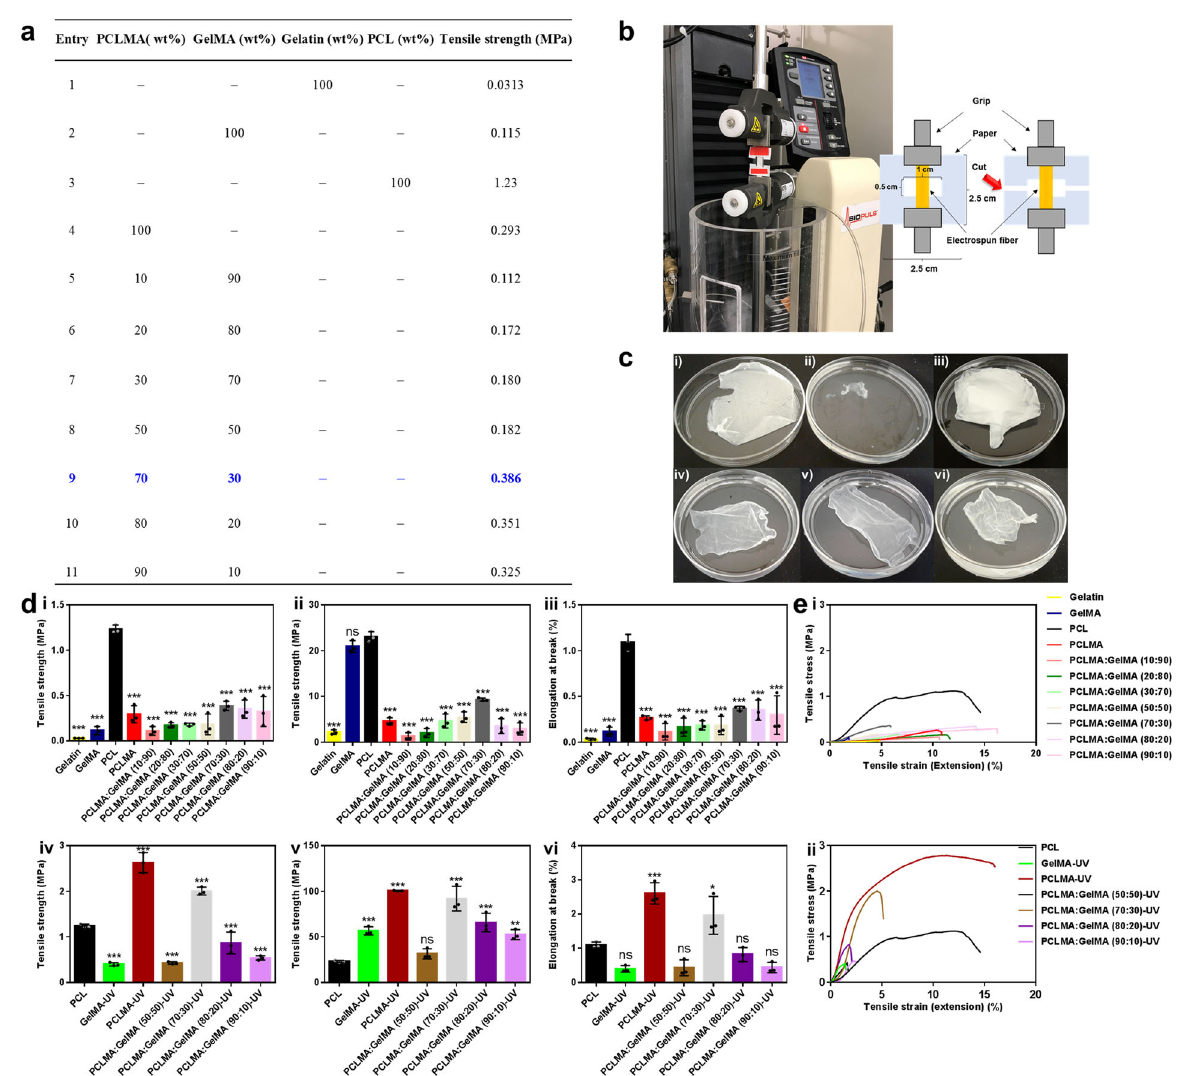
Fig. 3 Screening studies and mechanical evaluation of various nano fi ber compositions. a Table demonstrating the various compositions and their respective tensile strength. All the pure fi bers were prepared in a 10 wt.% stock solution and mixed in various ratios, therefore, the wt.% in the table indicates wt.% employed of the stock solution. For all the sample mixtures prior to electrospinning, Hexa fl uoroisopropan-2-ol (HFIP) was employed as the solvent and the fi nal volume for each solution was 5 ml. b The tensile test setup of the electrospun fi bers with a mechanical tester. c Images of the electrospun fi bers. i GelMA fi ber in a petri dish. ii GelMA fi ber in phosphate-buffered saline (PBS) immediately disintegrated. iii The hydrophobic and stable PCL fi ber in PBS solution. iv The stable PCLMA fi ber in PBS. v The PCLMA:GelMA (70:30) fi ber blend in PBS. vi The PCLMA:GelMA (70:30) fi ber blend after UV crosslinking in PBS. d Mechanical data of the various electrospun fi bers before crosslinking i tensile strength, ii elastic modulus, and iii elastic elongation at break, and correspondingly after crosslinking iv tensile strength, v elastic modulus and vi and elastic elongation at break. e The tensile stress vs. tensile strain data for the samples before and after crosslinking. Values are mean ± SD, N = 3. ANOVA ( p < 0.05) following by Tukey ’ s multiple comparisons test. The data were compared to solely PCL (*) p < 0.05, (**) p < 0.01, (***) p < 0.005, ns: not signi fi cant, mean statistical differences. The numeral post the fi ber name indicates the ratio of the materials of the respective blend (e.g., PCLMA:GelMA (10:90) means 10% PCLMA and 90%